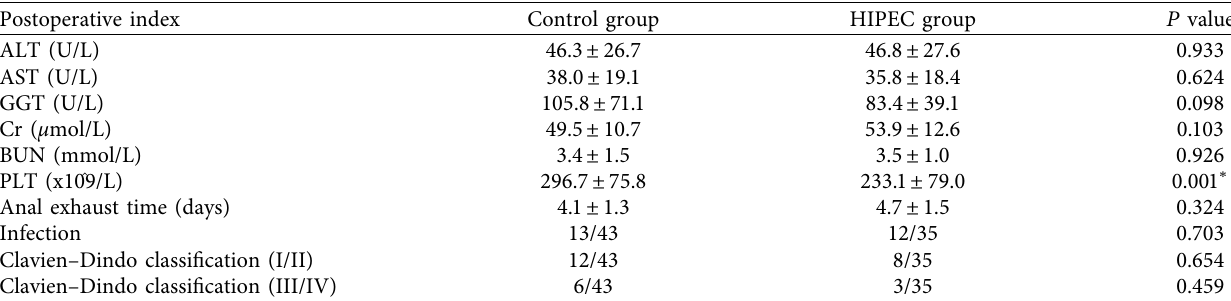
Table 2: Postoperative index of GBC patients.